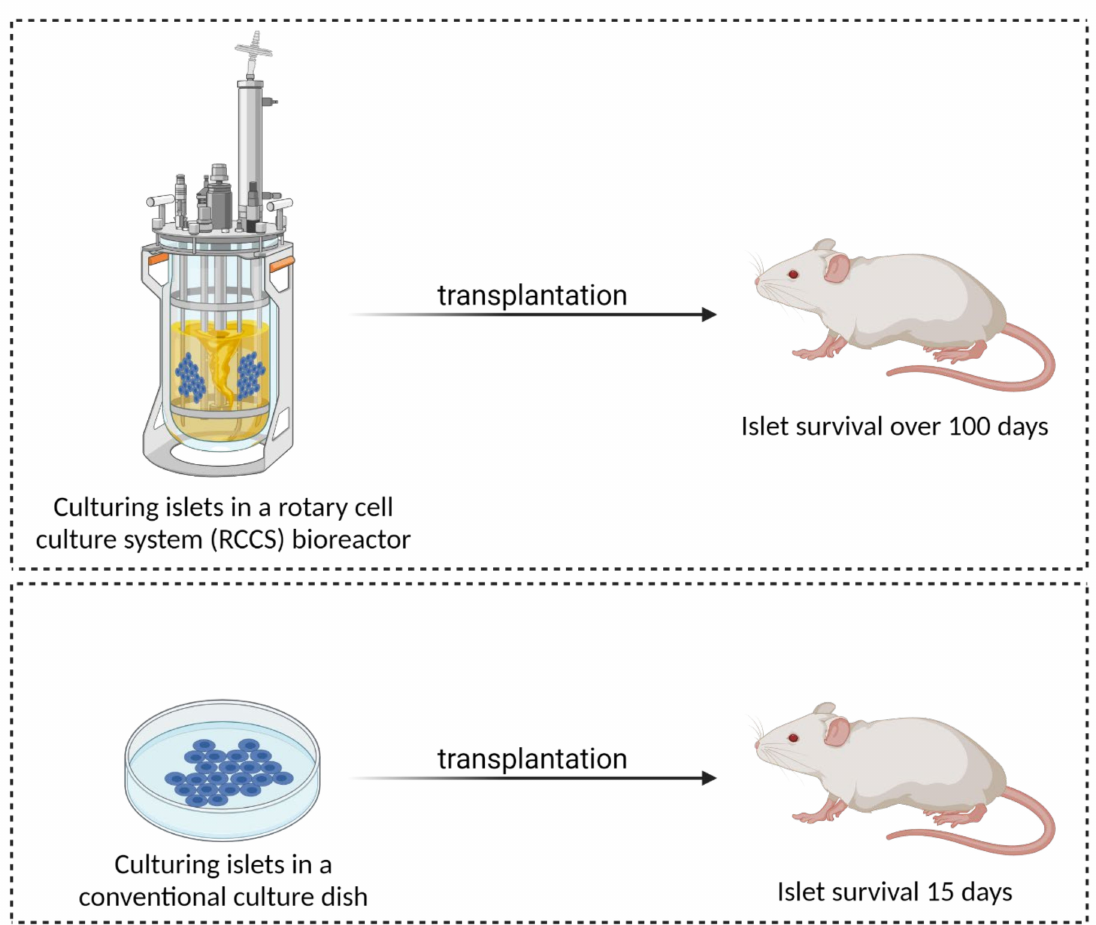
Figure 6. A comparison of conventional culture dish culturing and culturing in a rotary cell culture system (RCCS) bioreactor (created with BioRender.com; accessed on 6 July